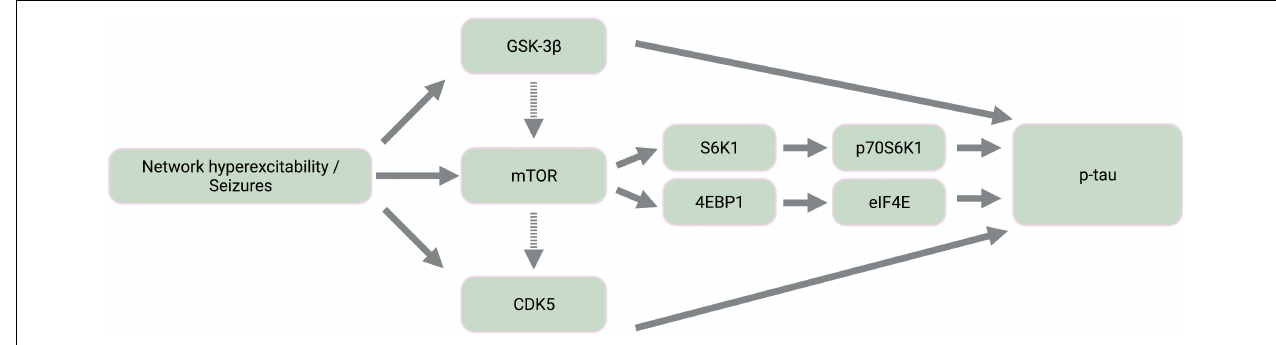
FIGURE 2 | Simplified diagram of activated kinase signaling cascades in epilepsy. Epileptic activity leads to the activation of tau kinases, GSK-3 β and CDK5, as well as mTOR. Dashed-line arrows indicate indirect activation of mTOR by GSK-3 β through the mTOR complex 1 and of CDK5 by mTOR through amyloid- β aggregation and calpain activation. The downstream targets of mTOR activation involve the activation of additional tau kinases, p70S6K1 and eIF4E. GSK-3 β , glycogen synthase kinase-3 β ; mTOR, mammalian target of rapamycin; CDK5, cyclin-dependent kinase 5; S6K1, ribosomal protein S6 kinase 1; 4EBP1, 4E binding protein 1; p70S6K1, phosphorylated S6K1; eIF4E, eukaryotic translation initiation factor 4E; p-tau, abnormally phosphorylated tau. Created with